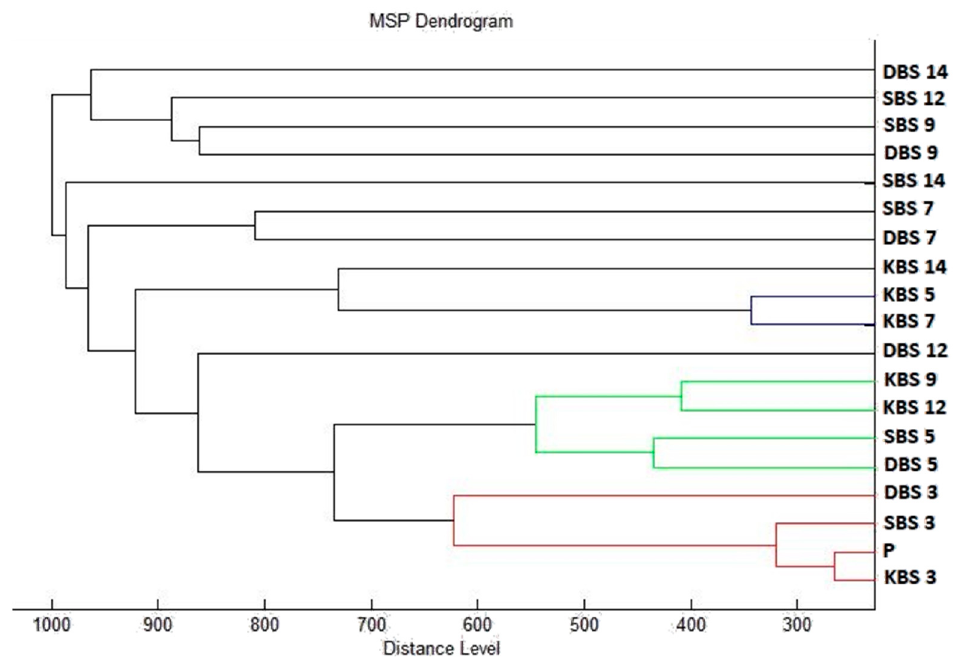
Figure 4. Dendrogram of B. subtilis generated using MSPs for the planktonic cells and the control. BS, B. subtilis ; K, control; S, glass; D, wood; P, planktonic cells.